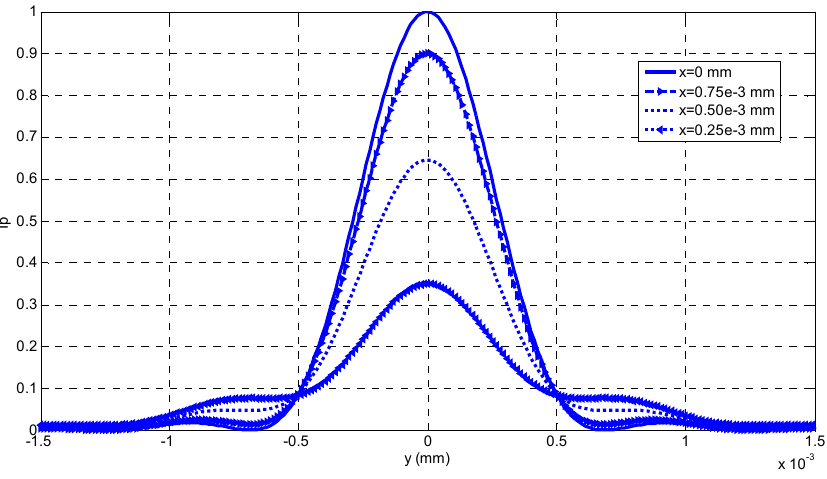
Figure 2. The intensity distribution curves of a random point P .